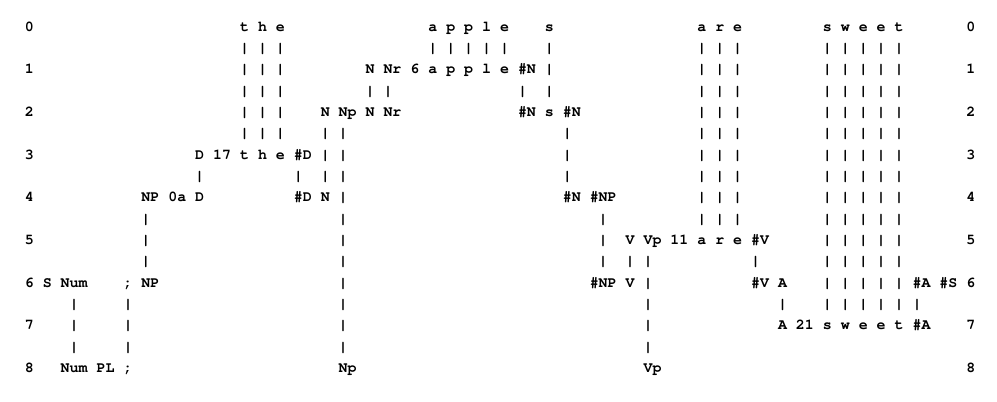
Figure 1. The best multiple alignment created by the SP computer model with a store of Old patterns like those in rows 1 to 8 (representing grammatical structures, including words) and a New pattern (representing a sentence to be parsed) shown in row